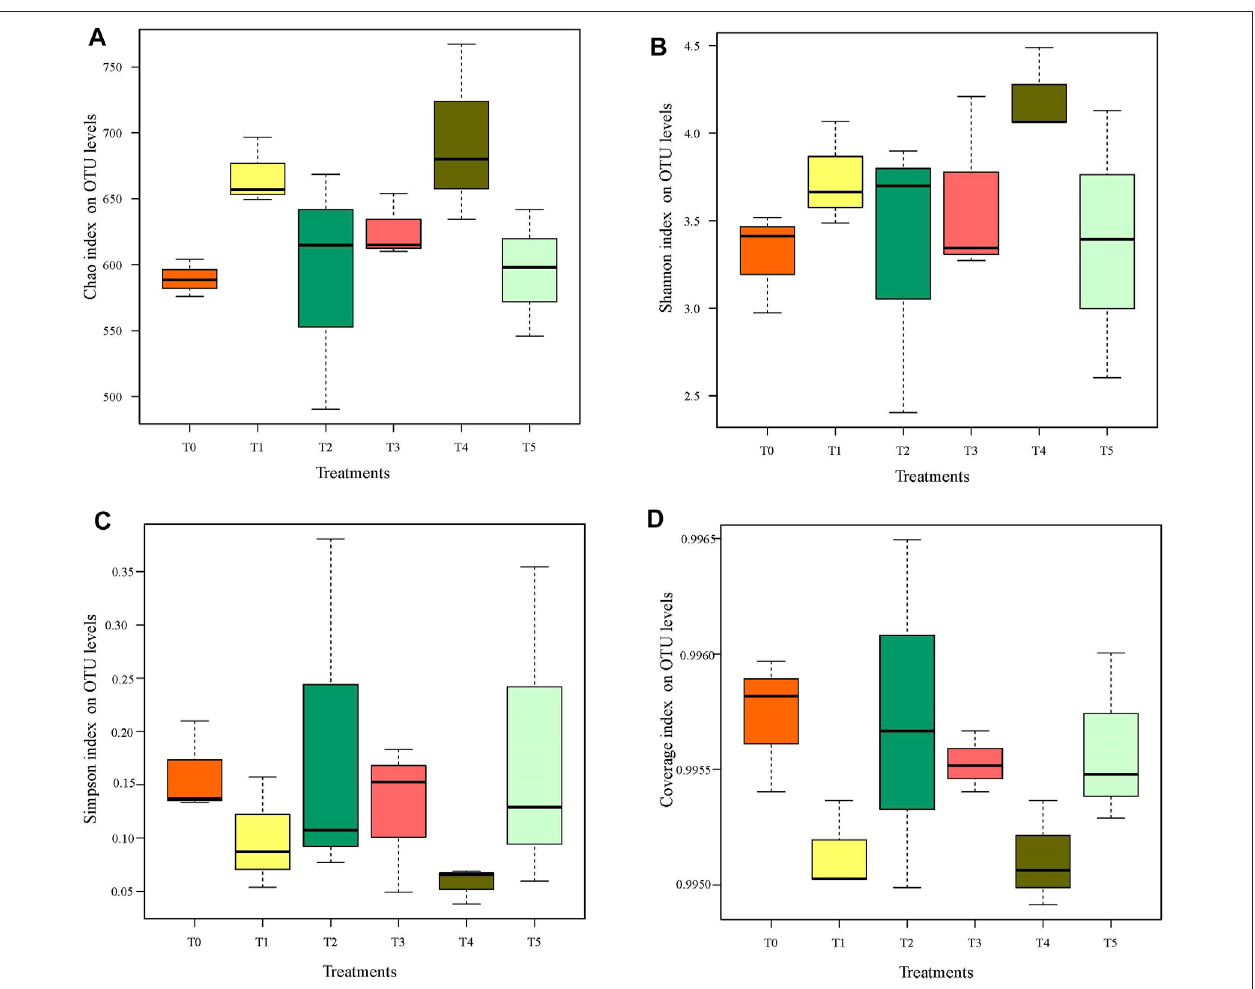
FIGURE 1 | Boxplots showing the in fl uence of antibiotic types (T0 to T5) on the alpha diversity of the bacterial community in swine manure composting: (A) the Chaoindex, (B) theShannonindex, (C) theSimpsonindex,and (D) thecoverageindex.T0:thecontrol,T1:CTCadded,T2:SMXadded,T3:LINadded,T4:CIPadded, T5:fourantibiotics(CIP+CTC+SMX+LIN)added,thesamebelow.DifferencesamongBacterialCommunitiesattheOTULevelandChangesinRelativeAbundanceof their Members at the Family